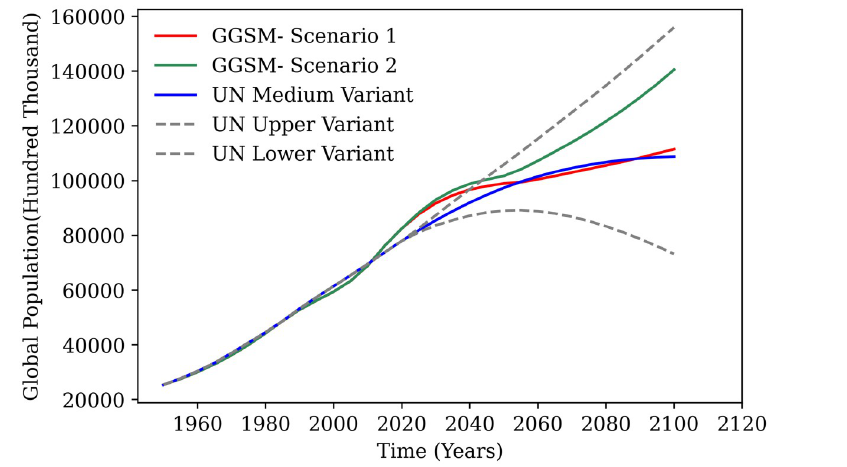
Fig 9. Profile of human population compared to UN projections